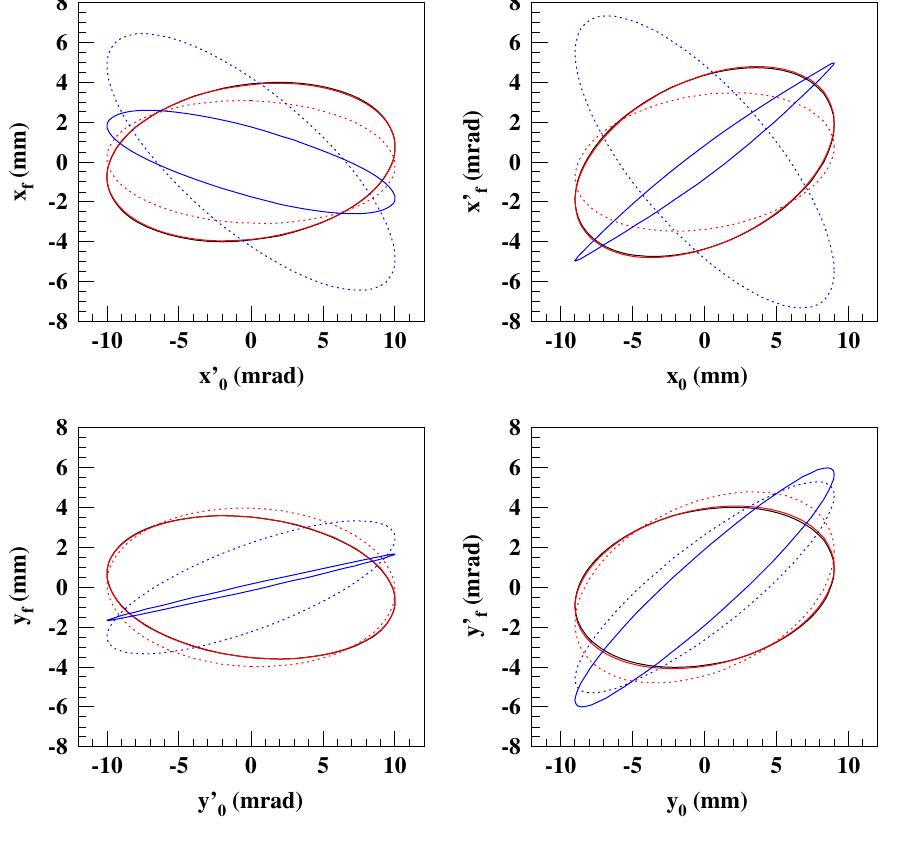
FIG. 4. Final coordinates after tracking through a quadrupole mag- net as evaluated with RADIA (black, solid line) and with STGFM for different expansion orders (see the text). All particles are initially equally distributed on the rim of a horizontal phase space ellipse with displacement. Top: ð x 0 ;x 0 0 ;y 0 ;y 0 0